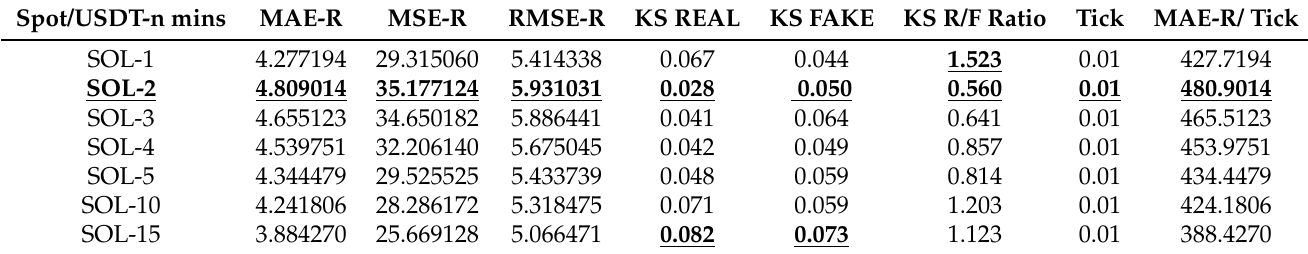
Table 13. We examined SOLUSDT spot prices against generated prices at one, two, three, four, five, ten and fifteen minute intervals. For KS R/F Ratio, three out of seven are bigger than one, where the highest KS REAL and FAKE are 0.082 and 0.073.